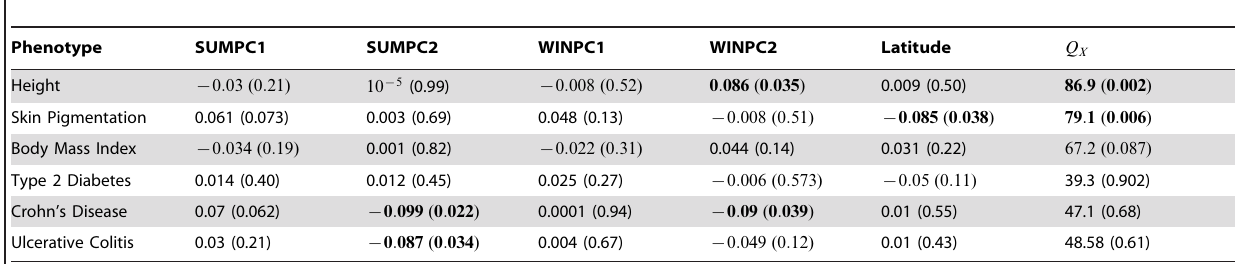
Table 2. Climate Correlations and Q X statistics for all six phenotypes in the global